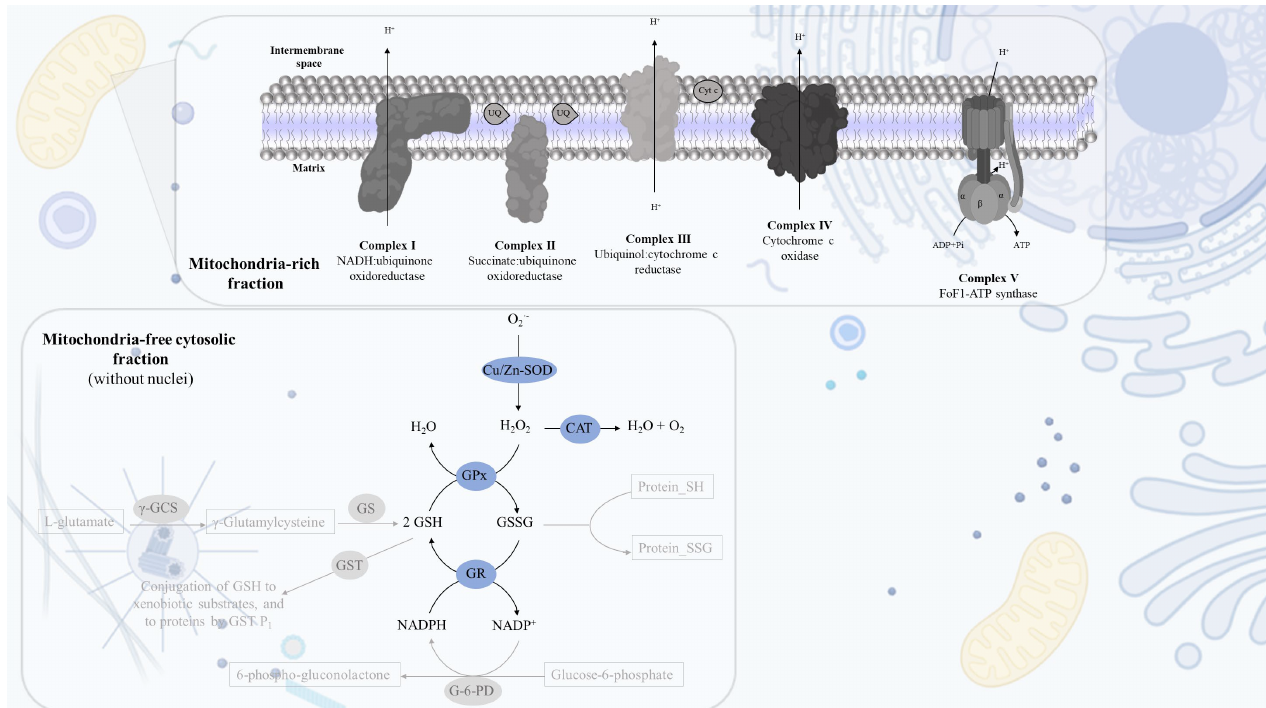
Figure 1. Schematic representations of the electron respiratory chain and the antioxidant defense system within the cell. The mitochondrial redox chain is composed of Complex I (NADH:ubiquinone oxidoreductase), Complex II (succinate:ubiquinone oxidoreductase), Complex III (ubiquinol:cytochrome c reductase), Complex IV (cytochrome c oxidase) and Complex V (FoF1-ATP synthase) in the inner mitochondrial membrane on cristae. Antioxidant enzymes mainly: Cu/Zn-SOD that is responsible for catalyzing the dismutation of O 2• − into H 2 O 2 and O 2 ; CAT promotes the conversion of H 2 O 2 into H 2 O and O 2 ; GPx reduces the H 2 O 2 into H 2 O oxidizing two molecules of GSH to form an oxidized dimer GSSG; and GR that uses the reducing power of